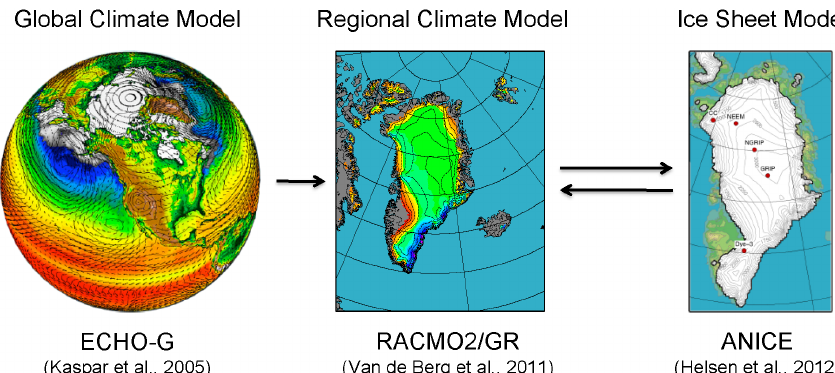
Fig. 1. Schematic outline of the asynchronous model coupling. An Eemian run of the ECHO-G global climate model is used as lateral boundaries for the regional atmospheric climate model, which in turn computes SMB, T s and refreezing that are used as forcing for the ice sheet model. Every 1.5kyr, the changed ice sheet topography and extent are updated in the regional atmospheric climate model, after which new fields of SMB, T s and refreezing are calculated,